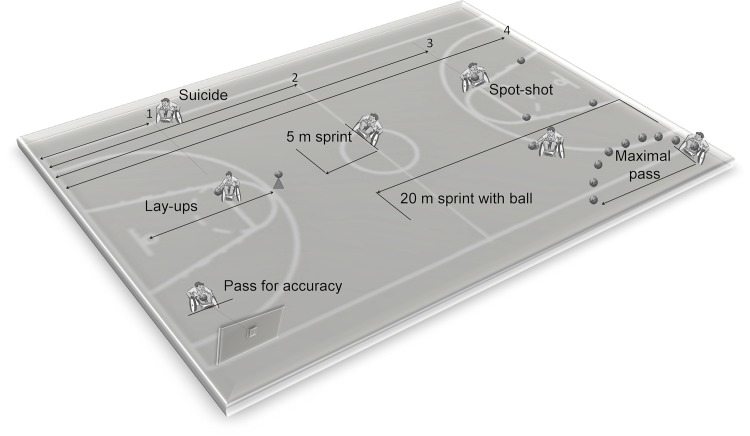
Layout of sport-specific field tests adopted in this study.See text for details.